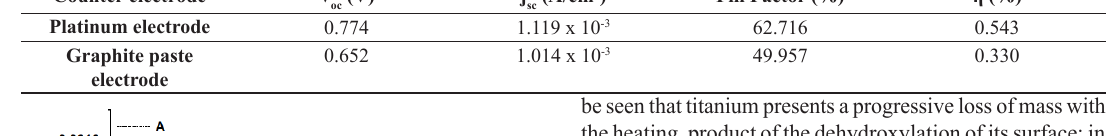
Table 4. j x V curve results of cells using platinum and graphite paste electrode. Counter electrode